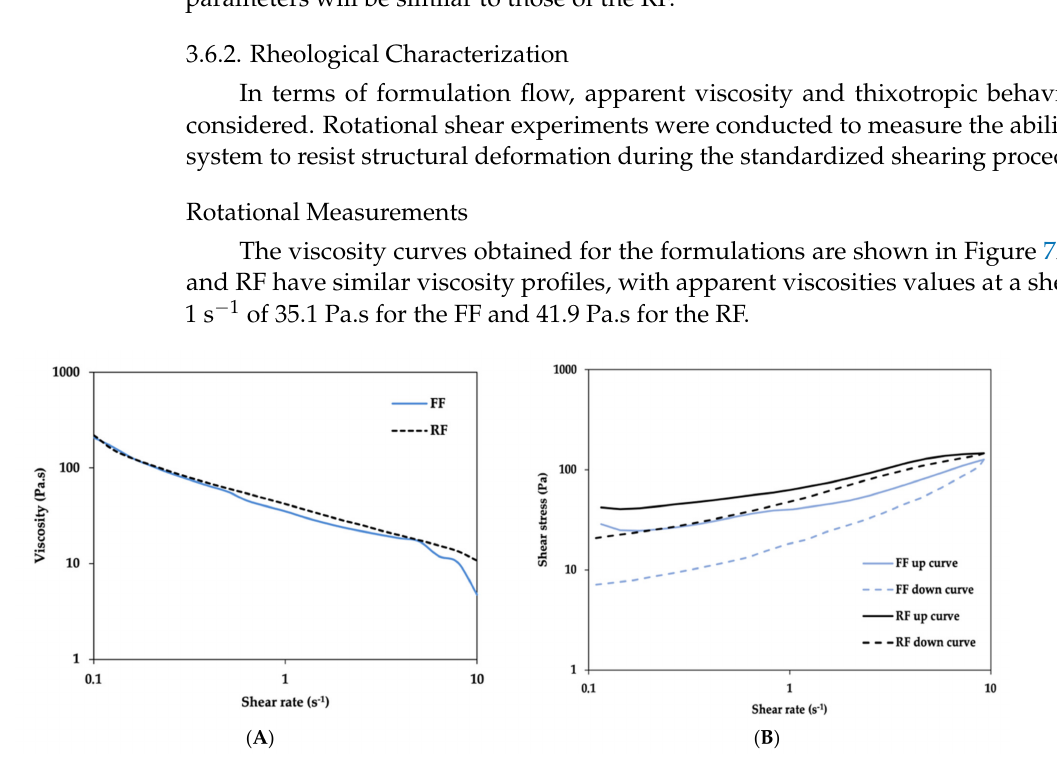
Figure 7. Viscosity profile of the FF and RF ( A ) and Flow curves represented by shear stress as a function of shear rate for the FF and RF ( B ). Data shown are means, n =